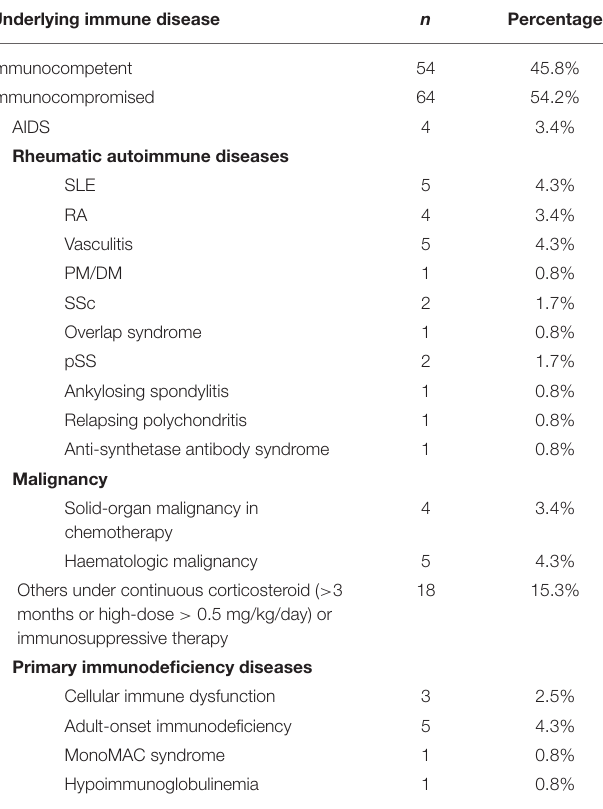
TABLE 1 | Characteristics and predisposing conditions in patients with NTM infections ( n = 118). Underlying immune